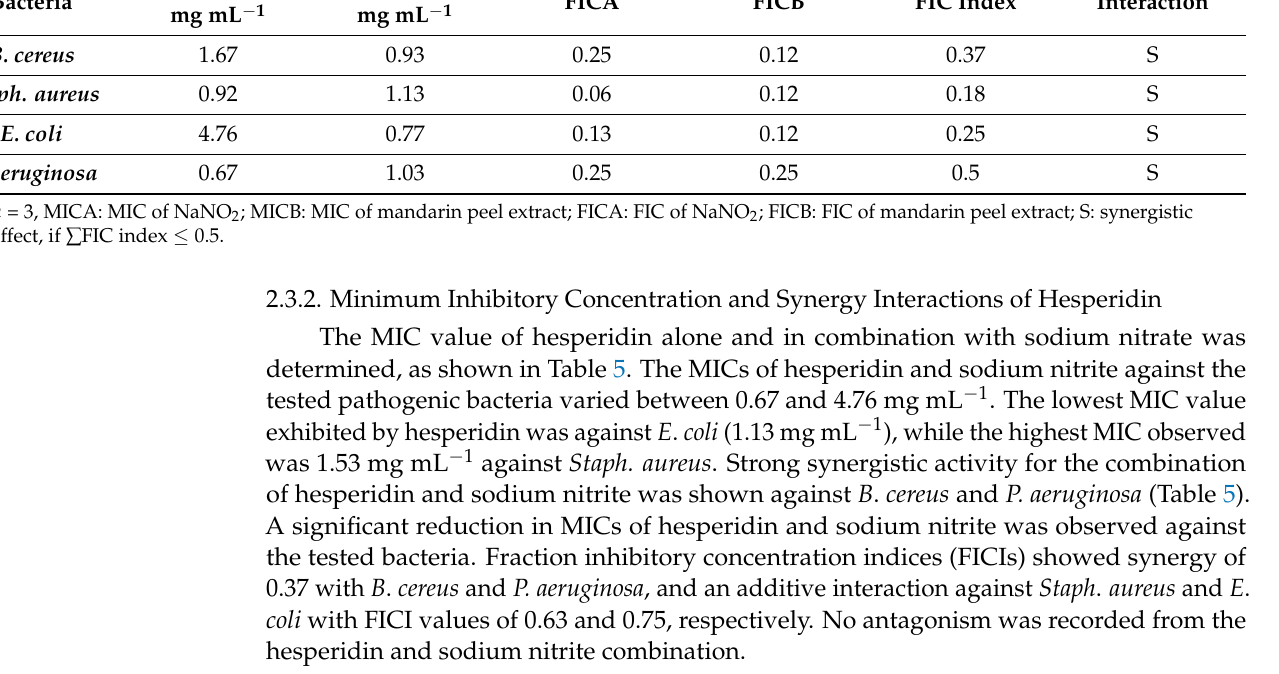
Table 4. Synergic interaction between mandarin peel extract with NaNO 2 against the tested foodborne pathogenic bacteria. Bacteria